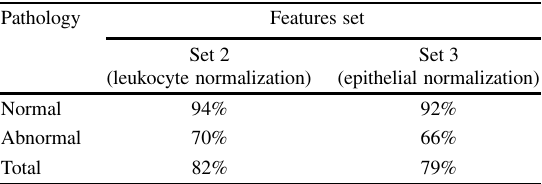
Percentage of correct classification of normal and abnormal speci- men given by a stepwise discriminant analysis using features set 2 and 3. F -to-enter: